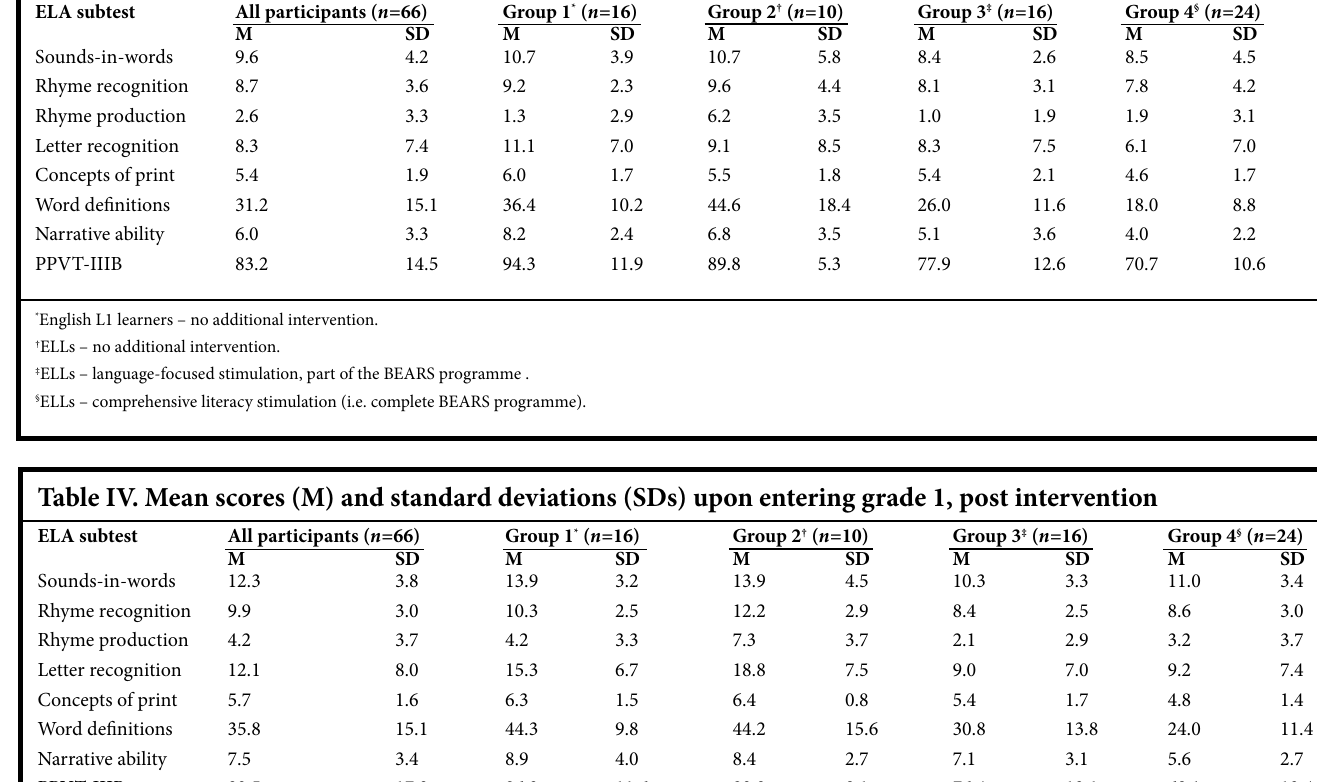
table iii. pre-intervention mean scores (M) and standard deviations (SDs), 4 months prior to entering grade 1 ELA subtest